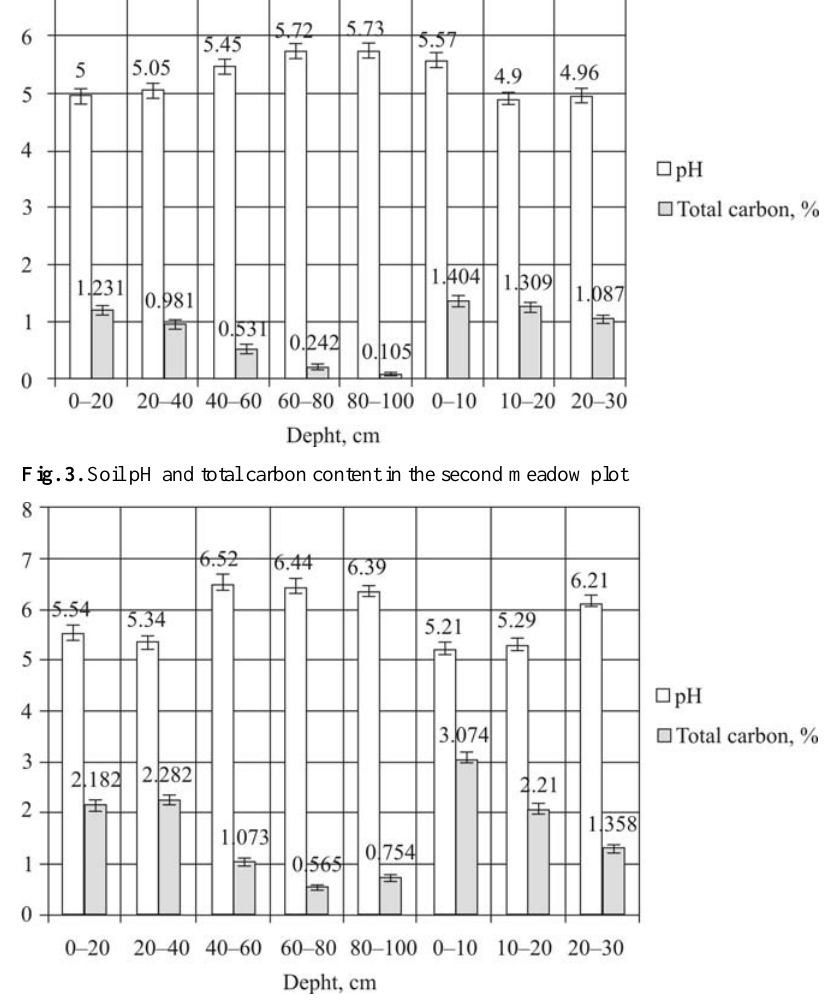
Fig. 4. Soil pH and total carbon content in forest